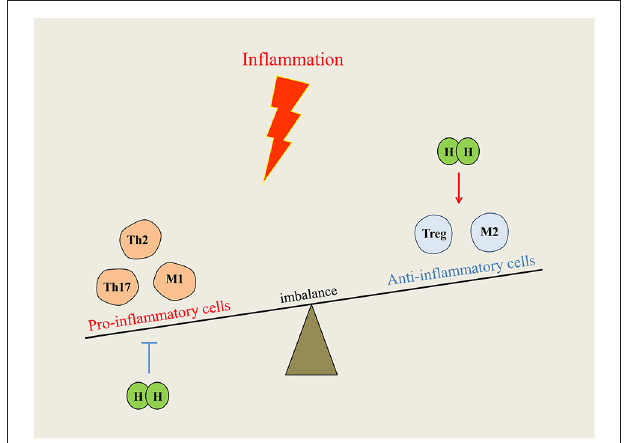
FIGURE 3 | Immunomodulatory function of hydrogen on immune system. When inflammation occurs, the disordered immune cells break the balance of immune homeostasis. Hydrogen intervention could reduce inflammation by downregulating proinflammatory cells or upregulating anti-inflammatory cells, and the imbalance can be